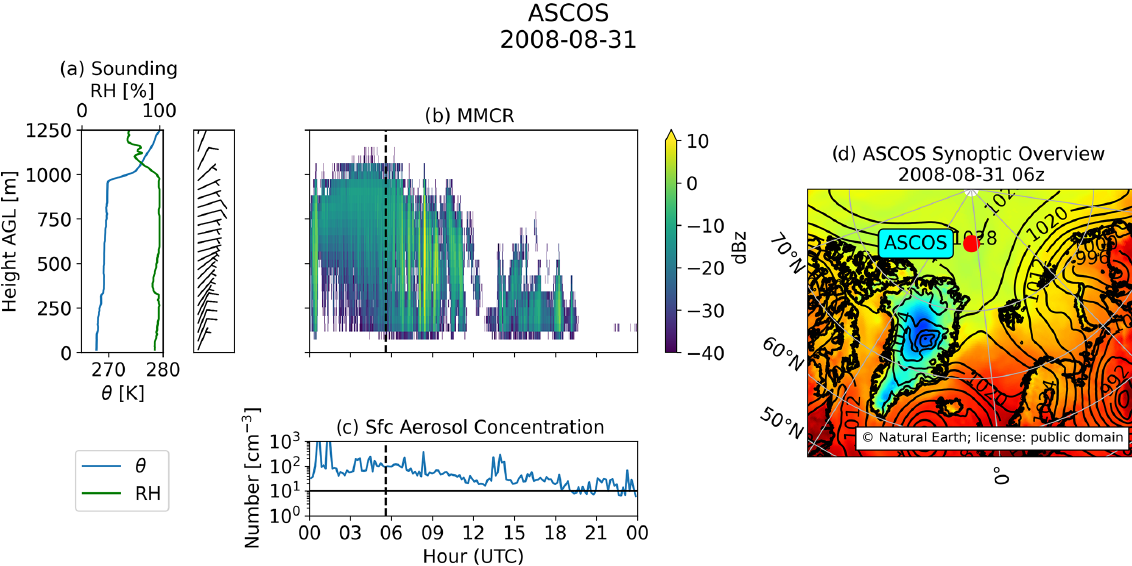
Figure 3. Same as Fig. 2 for the ASCOS